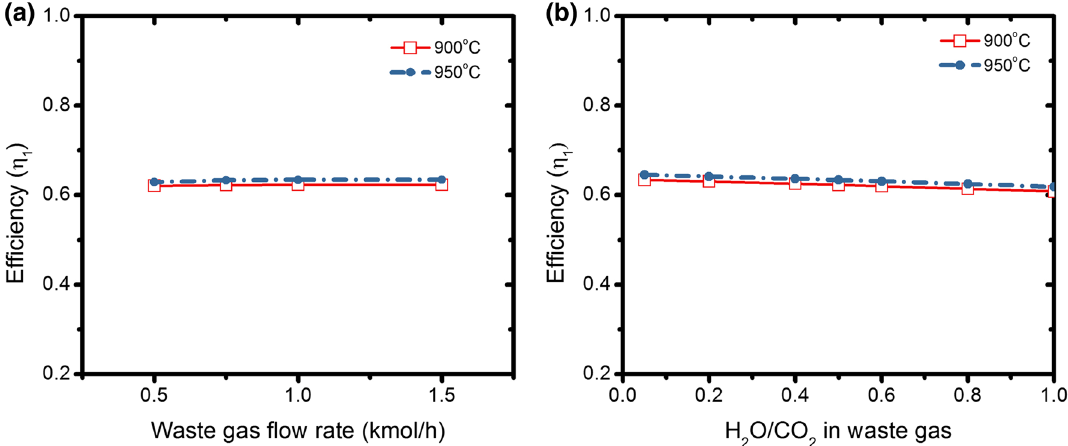
Fig. 9 Variation of system efficiency considering syngas from both the reactors ( h 1 ) based on the parametric variations within the oxida- tion reactor, at a constant CH 4 /CeO 2 flow ratio of 0.8 in the reduction